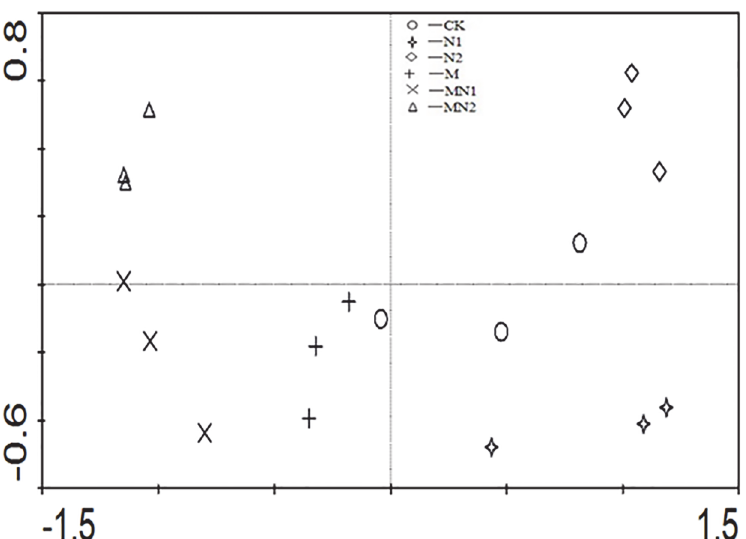
Fig 6. Principal component analysis of soil enzyme activities in the different treatments (CK unfertilized control; N1 300 kg fertilizer N ha -1 ; N2 600 kg fertilizer N ha -1 ; M composted manure; MN1 combined application of composted manure and 300 kg N fertilizer ha -1 ; MN2 combined application of manure and 600 kg fertilizer N ha -1 ).